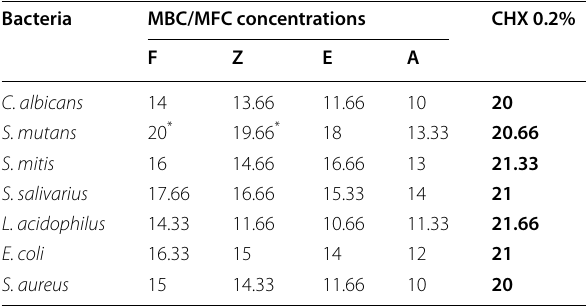
Table 4 Mean value of zones of inhibition (mm) of A, E, Z, F, and CHX 0.2% in Disc Agar Diffusion test